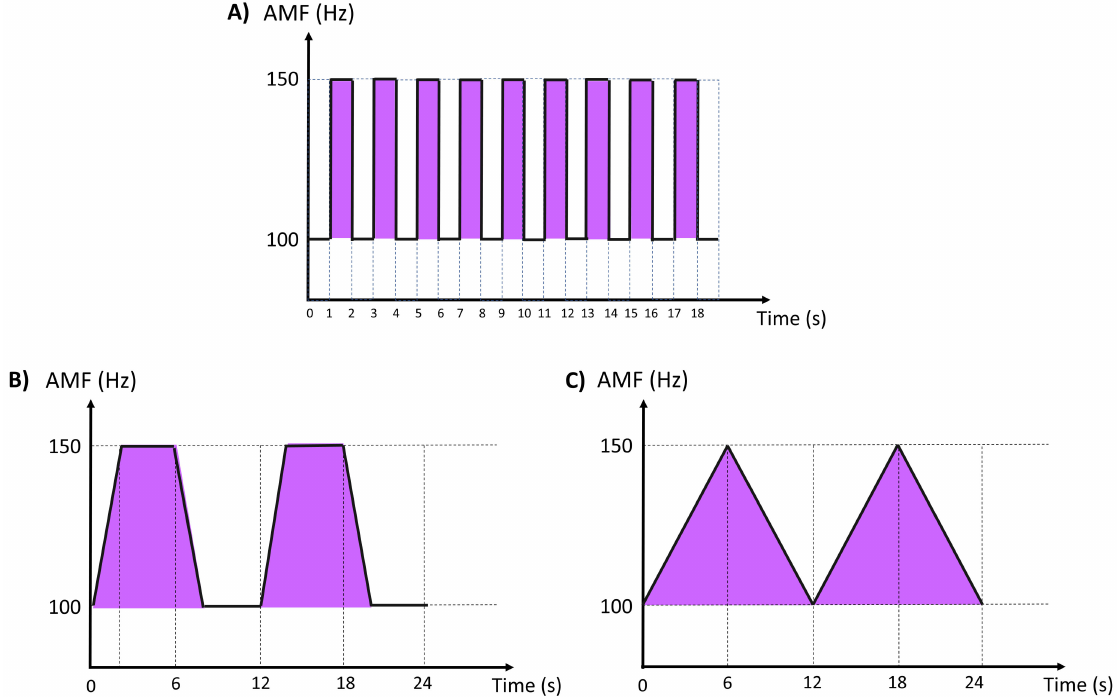
Figure 2. Sweep mode, slope or swing patterns: ( A ) 1:1—variation every 1 s; ( B ) 1:5:1—frequencies increase and decrease in 1 s and are maintained for 5 s; ( C ) 6:6—frequencies increase and decrease in 6 s; AMF: amplitude-modulated frequency; Hz: hertz; s: